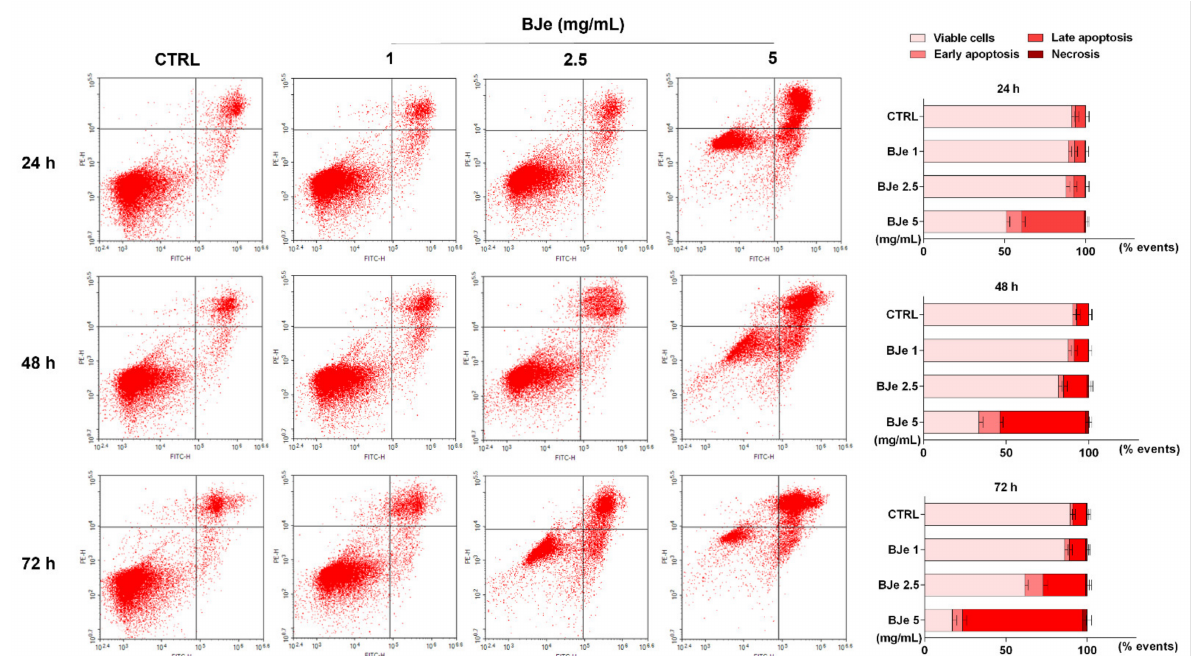
Figure 5. Cytofluorimetric evaluation of apoptosis in THP-1 cells exposed to BJe. The evaluation of apoptosis was performed by the Annexin V-FITC/PI assay. On the left, representative Annexin V vs. PI dot plots of the THP-1 cells treated with different concentrations (1–5 mg/mL) of BJe for the indicated times are displayed. Lower left quadrant contains the viable cells (Annexin V − /PI − ), lower right quadrant contains the cells in early apoptosis (Annexin V + /PI − ), upper right quadrant contains the cells in late apoptosis (Annexin V + /PI + ), while upper left quadrant contains the necrotic cells (Annexin V − /PI + ). On the right, histograms report the percentages of cells for each quadrant ± SEM of three independent experiments performed in triplicate ( n =